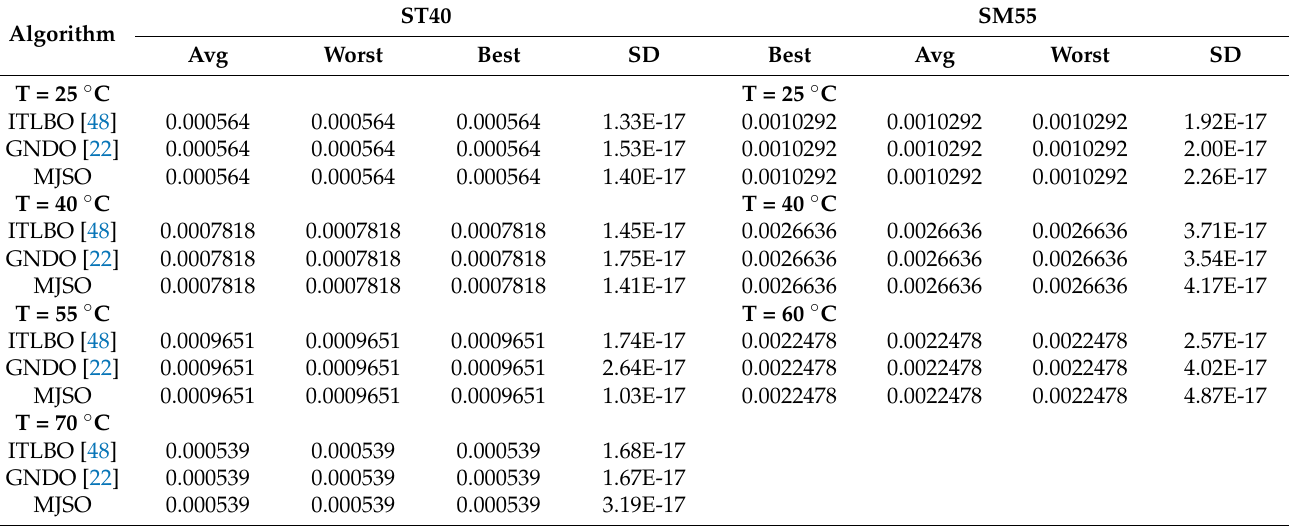
Table 15. Comparison at various T and G = 1000 W/m 2